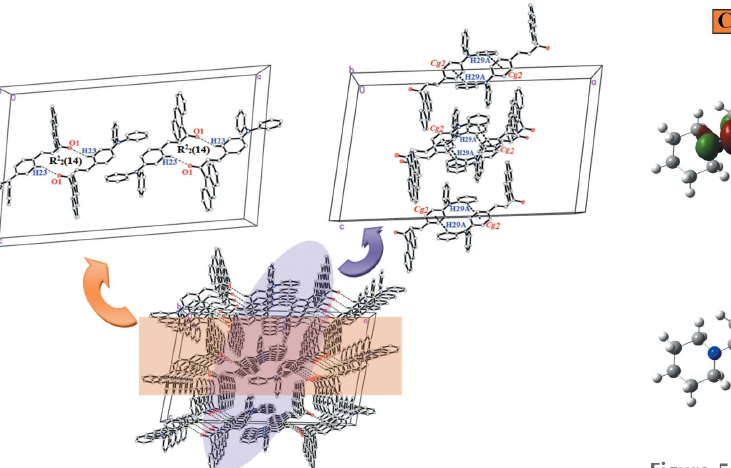
Figure 3 The weak C—H (cid:2)(cid:2)(cid:2) O and C—H (cid:2)(cid:2)(cid:2) (cid:2) interactions in compound (II).